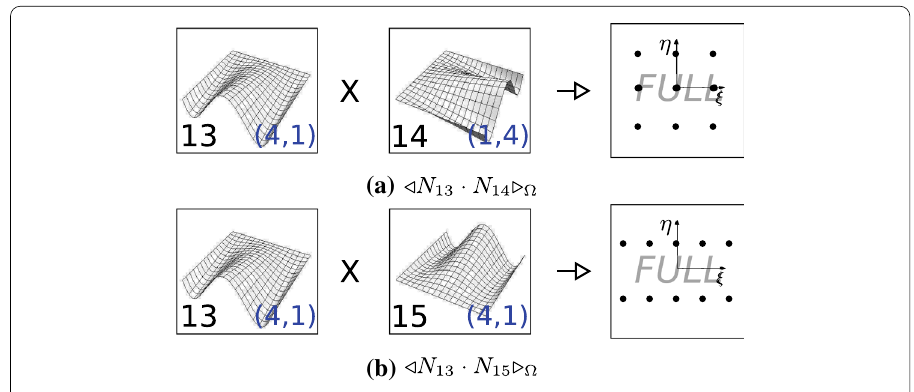
Fig. 3 Gauss points used for the full integration of hierarchical shell elements. “FULL” represents the adoption of the full integration approach